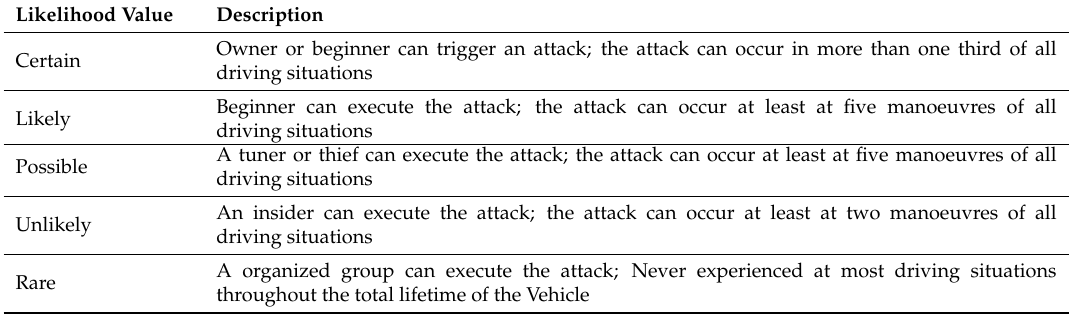
Table 9. Qualitative Likelihood Scale for Vehicles.